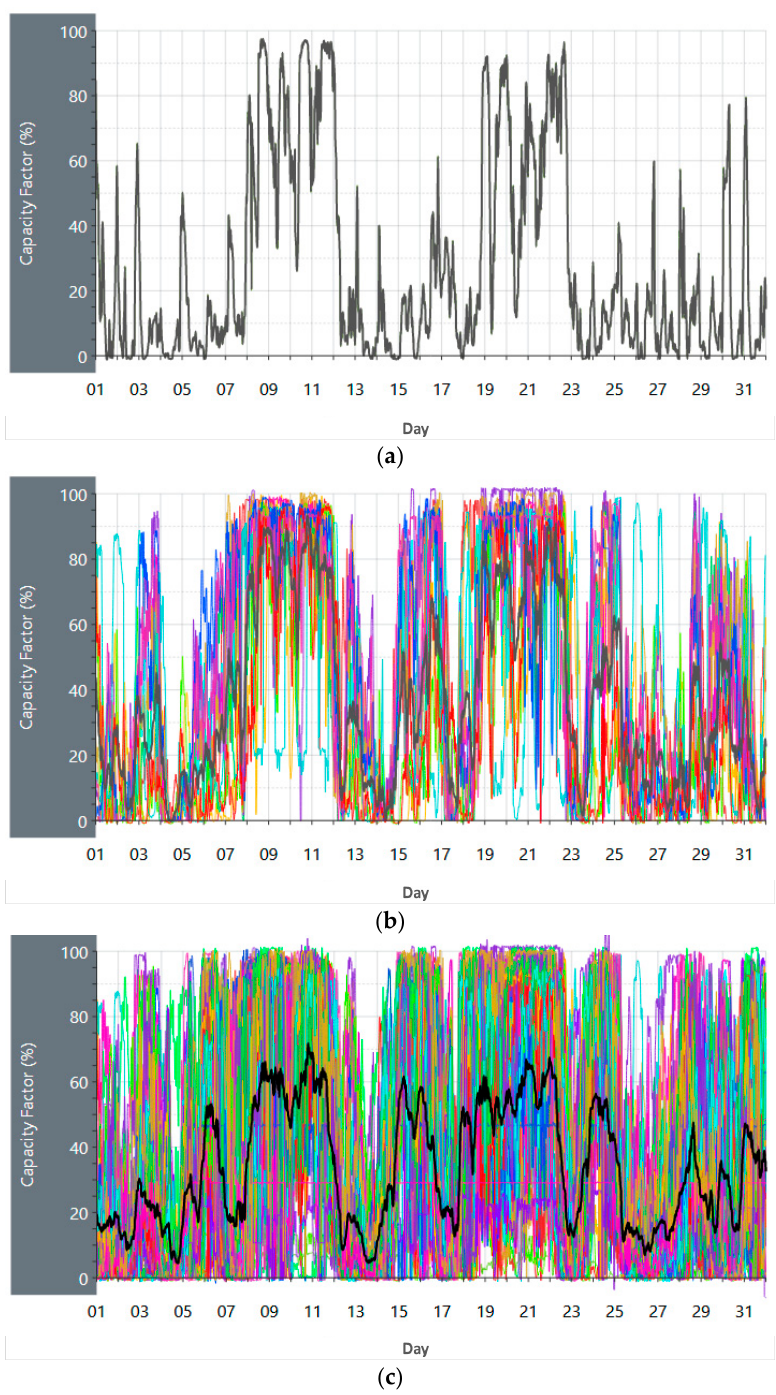
Figure 1. Wind energy production, during August 2019, measured with a 3 minutes sampling frequency, of ( a ) Sapphire wind energy facility (WEF). ( b ) All the WEFs in New South Wales. ( c ) All the WEFs of the National Electricity Market (NEM) grid. Images reproduced modified from [48]. The individual WEFs are shown in different colors. The tick line is the grid average value. This image shows the correlation between WEFs even over a significant area, and the extent of the fluctuations even at the grid average value. X-axis time, days; Y-axis capacity factor ε (generating power vs. registered power), non-dimensional.